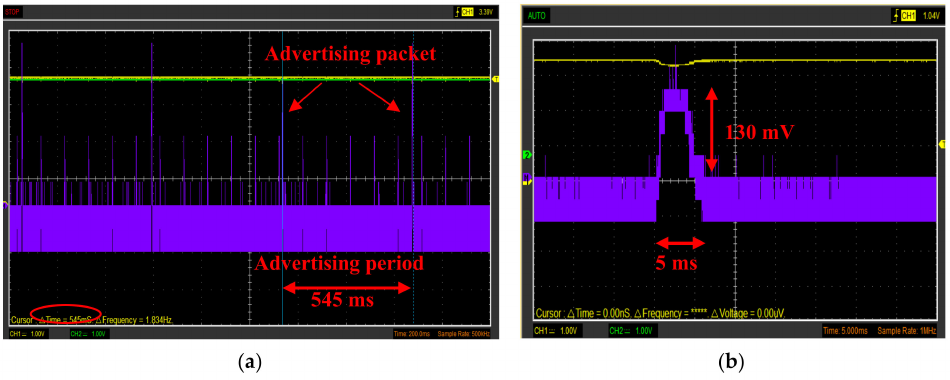
Figure 18. ( a ) Oscilloscope traces acquired during the iBeacon modality of the BLE smart tag; every 546.25 ms an advertising packet is transmitted, indicated by a peak of the voltage drop on the sensing resistor; ( b ) the peak voltage drop is equal to 130 mV, corresponding to an absorbed current value of 13